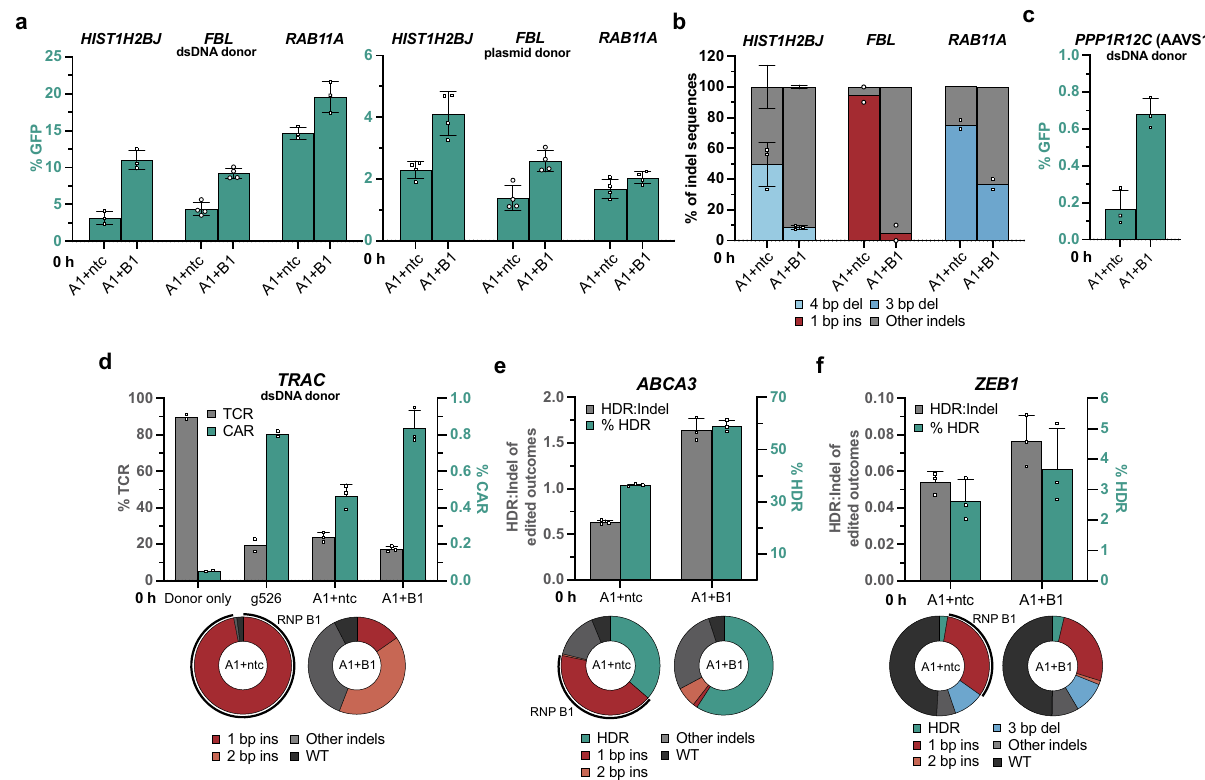
Fig. 3 Recursive Editing increases incorporation of large cargo and therapeutically relevant SNPs. a Carboxy-terminal GFP tagging ef fi ciency of the indicated genes with Recursive Editing in K-562 cells. b Editing outcomes at the indicated target sites without the presence of an HDR donor molecule using Sanger sequencing. c Insertion ef fi ciency of GFP at PPP1R12C (AAVS1) with Recursive Editing in K-562 cells. d Installation ef fi ciency of a chimeric antigen receptor (CAR) at TRAC with Recursive Editing in CD4 + T cells. Left y-axis corresponds to the percentage of cells expressing T cell receptor α / β (TCR) and the right y-axis to the percentage of cells expressing the CAR. g526 was a previously identi fi ed high performing gRNA 30 . Individual editing outcomes at TRAC in CD4 + T cells in the absence of a donor using Sanger sequencing are displayed below. The percentage of alleles targeted by RNP B1 are indicated by the outer curve. e , f Installation of pathogenic ClinVar variants with Recursive Editing in the listed genes in HEK-293T cells. Individual editing outcomes are displayed below for each locus. Each data point represents an individual biological replicate ( n = 2 – 4). Error bars + / − standard deviation